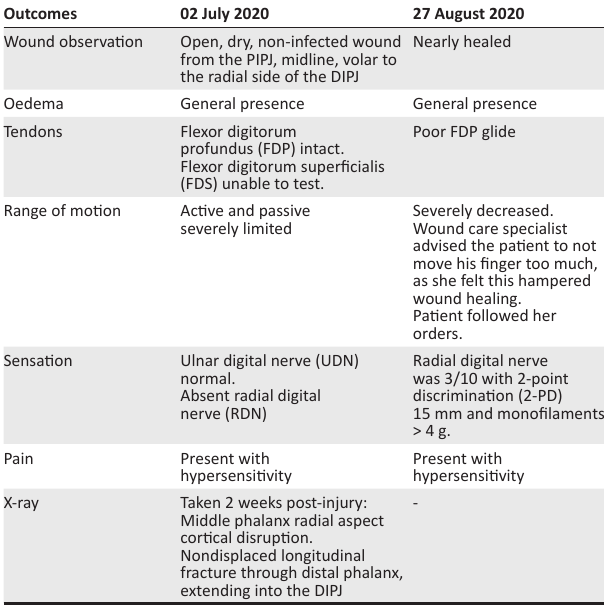
TABLE 1: Preoperative hand surgeon’s assessments.